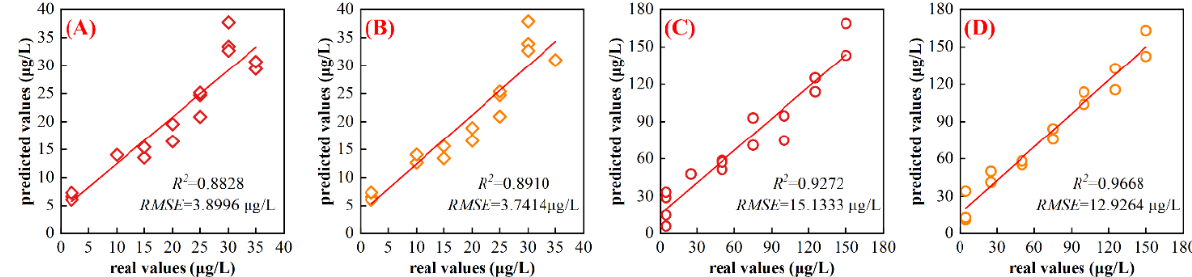
Figure 8. PLSR model results for Cd 2+ ( A , B ) and Pb 2+ ( C , D ) concentration detection in the validation dataset. (Diamond scatters represent Cd 2+ concentrations, circular scatters represent Pb 2+ concentrations, red scatters represent the model input as A manu , orange scatters represent A algo as the model input).